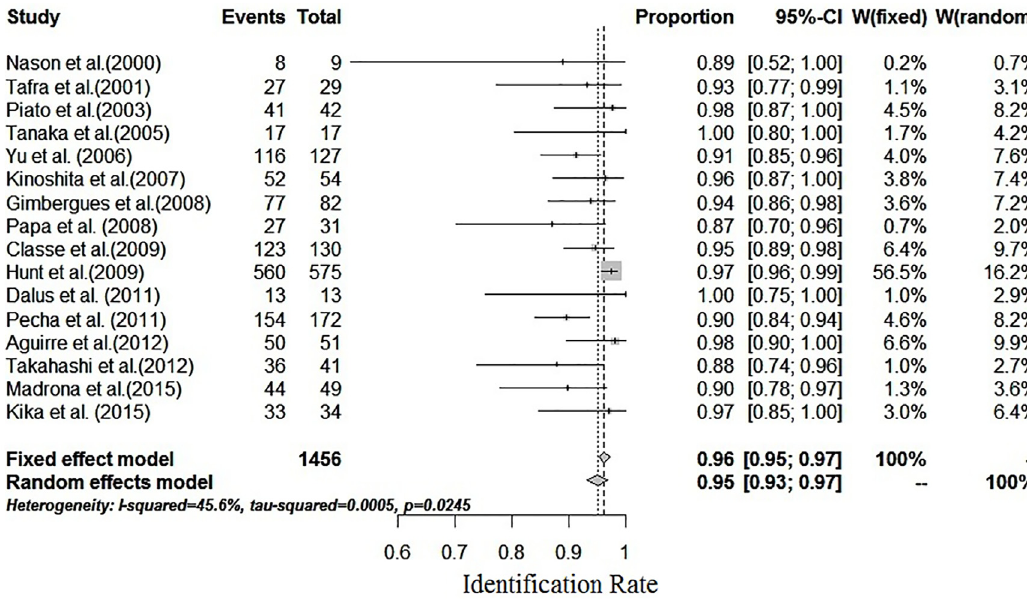
Fig 2. Forest plot of the IR. A fixed-effects model was used to estimate the combined IR, with a result of 96% (95% CI: 95%-97%); I 2 = 45.6%.